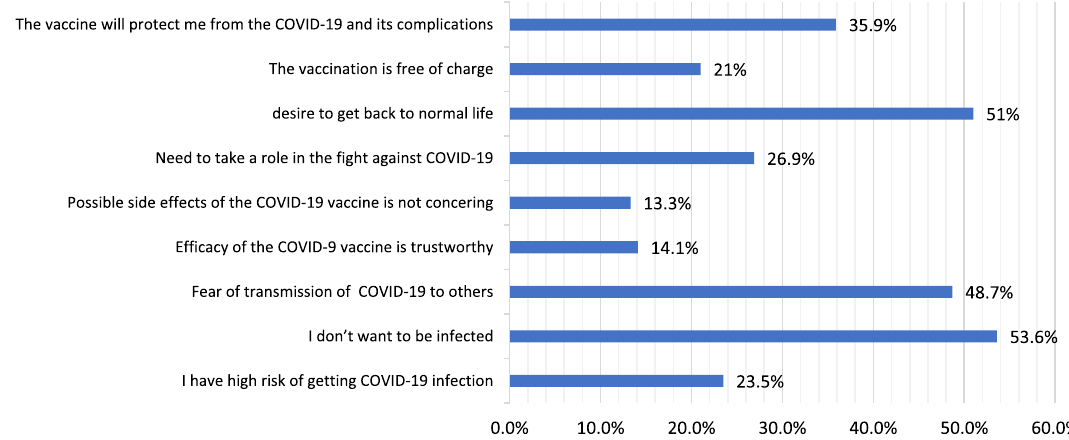
Fig. 4 The perceived motivators for COVID ‐ 19 vaccination among vaccine acceptant group ( n